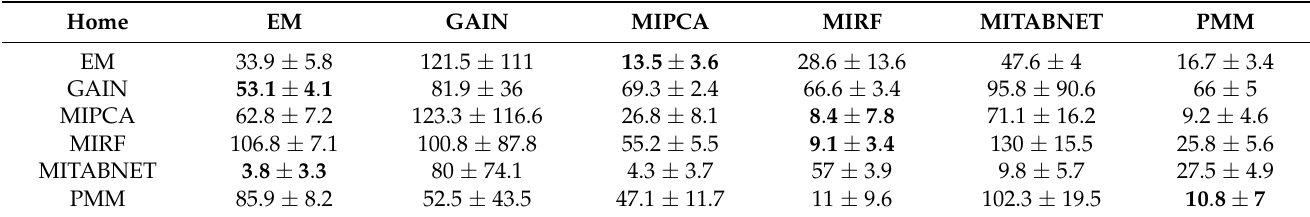
Table 5. Percentage bias for each imputation algorithm in the Flatiron NSCLC